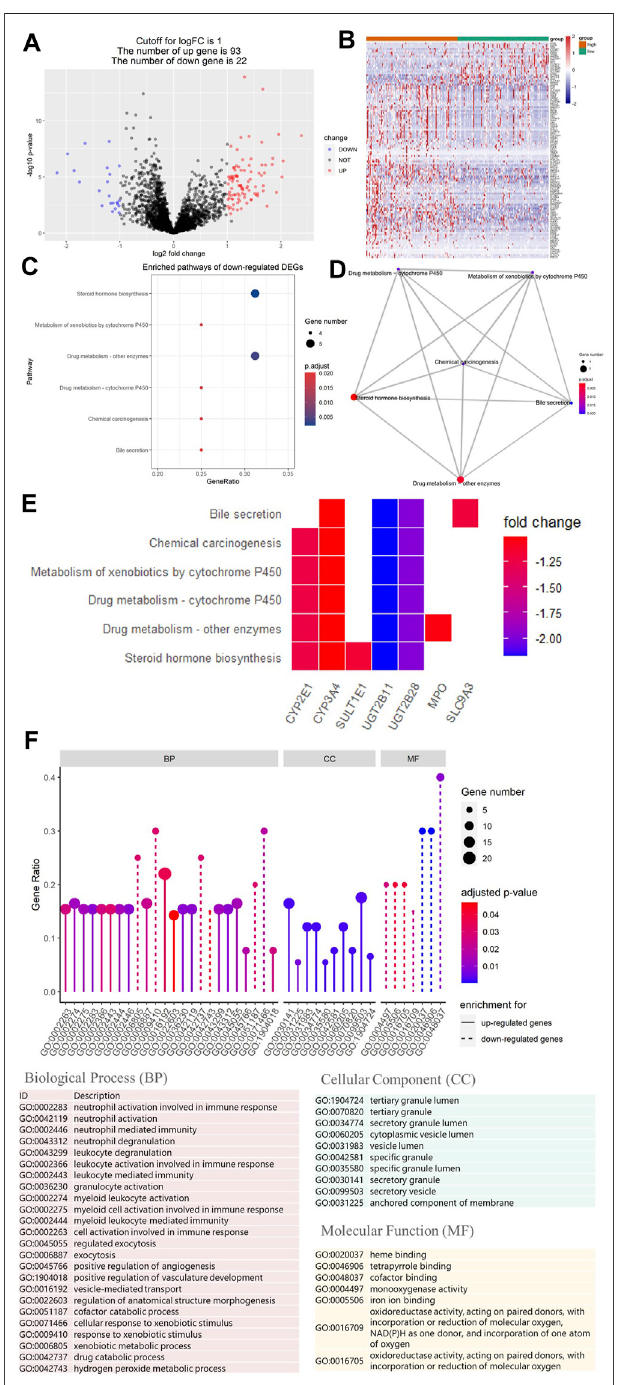
FIGURE 5 | Differential gene expression analysis of metabolic genes. And Kyoto Encyclopedia of Genes and Genomes (KEGG) and GeneOntology (GO) analysis of differentially expressed genes (DEGs). (A) Volcano plot showing DEGs between the top 25% samples of the high- and low-risk groups. Each dot represents one gene. Red dot represents upregulated gene (log2 (fold change) > 1 and p -value < 0.05). Blue dot represents downregulated gene (log2 (fold change) < − 1 and p -value < 0.05). And black dot represents non-differentially expressed gene. (B) Heatmap of DEGs ( Continued )